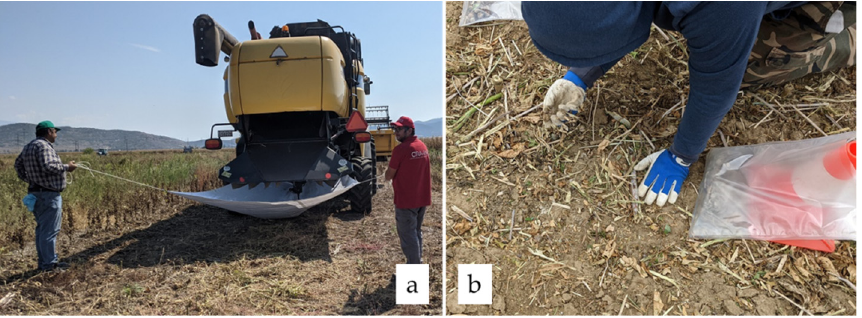
Figure 3. Collection of threshed biomass ( a ) and lost capsule ( b ) for CSL and ISL assessment, respec- tively.